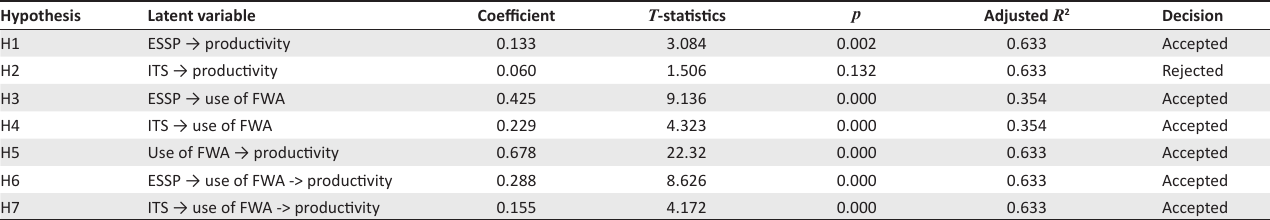
TABLE 3: Summary of results from the hypotheses.